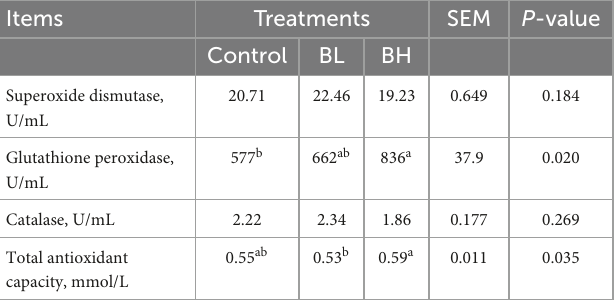
TABLE 4 Effects of biochanin A on antioxidant capacity of